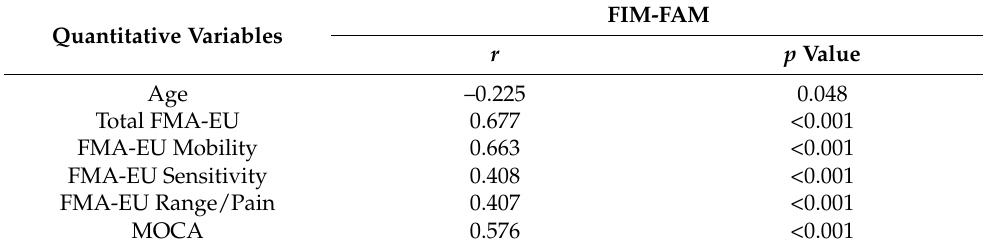
Table 4. Relationship between the different quantitative study variables and functional